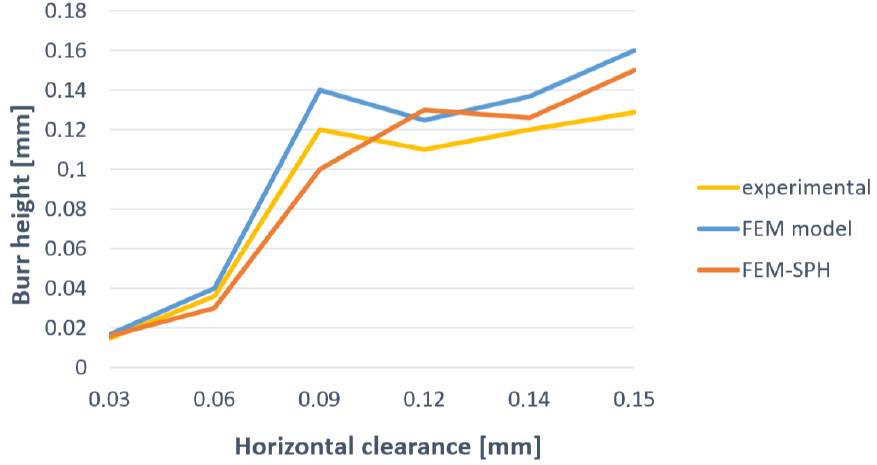
Figure 12. Graph of burr height obtained numerically and experimentally.